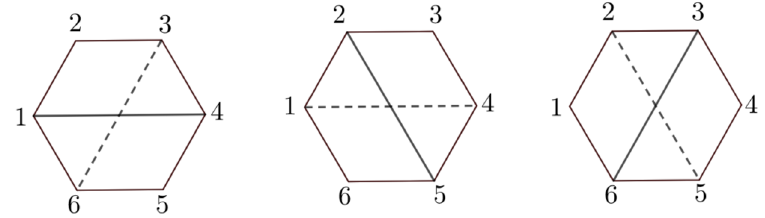
Figure 2 . All possible quadrangulations of a hexagon. The solid-line diagonals represents the reference quadrangulation Q and the dashed-line represents the Q -compatible